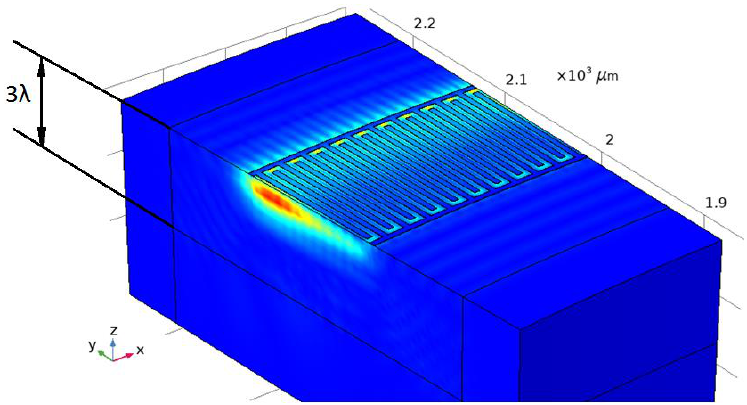
Figure 7. SAW-distribution on console surface.